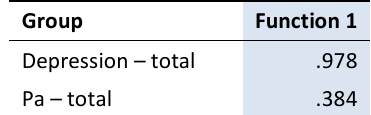
Table 10: Matrix of the discriminant function